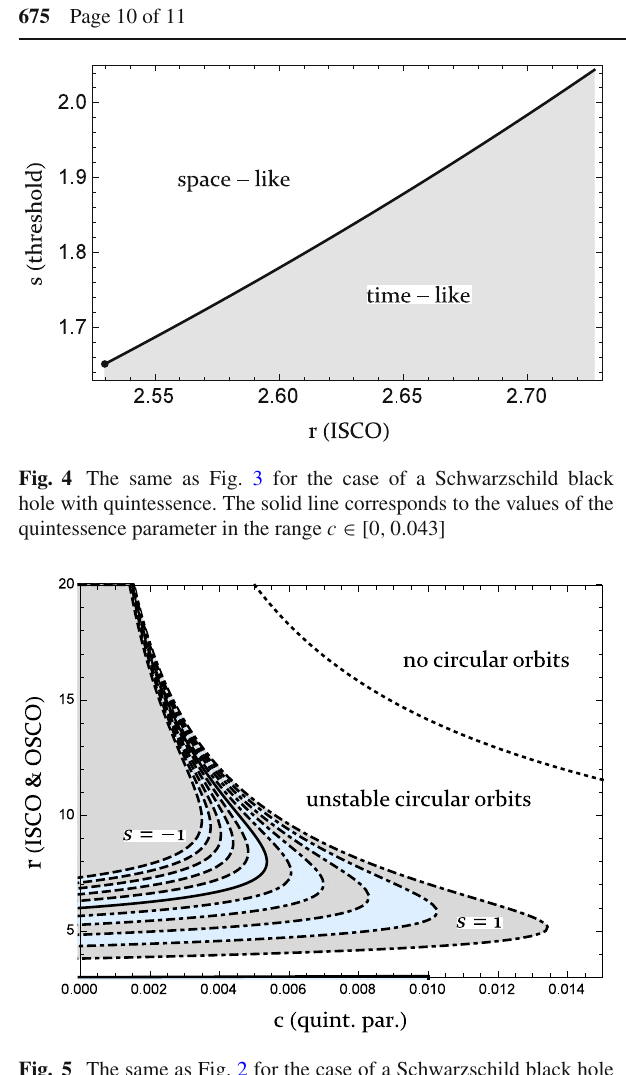
Fig. 5 The same as Fig. 2 for the case of a Schwarzschild black hole with